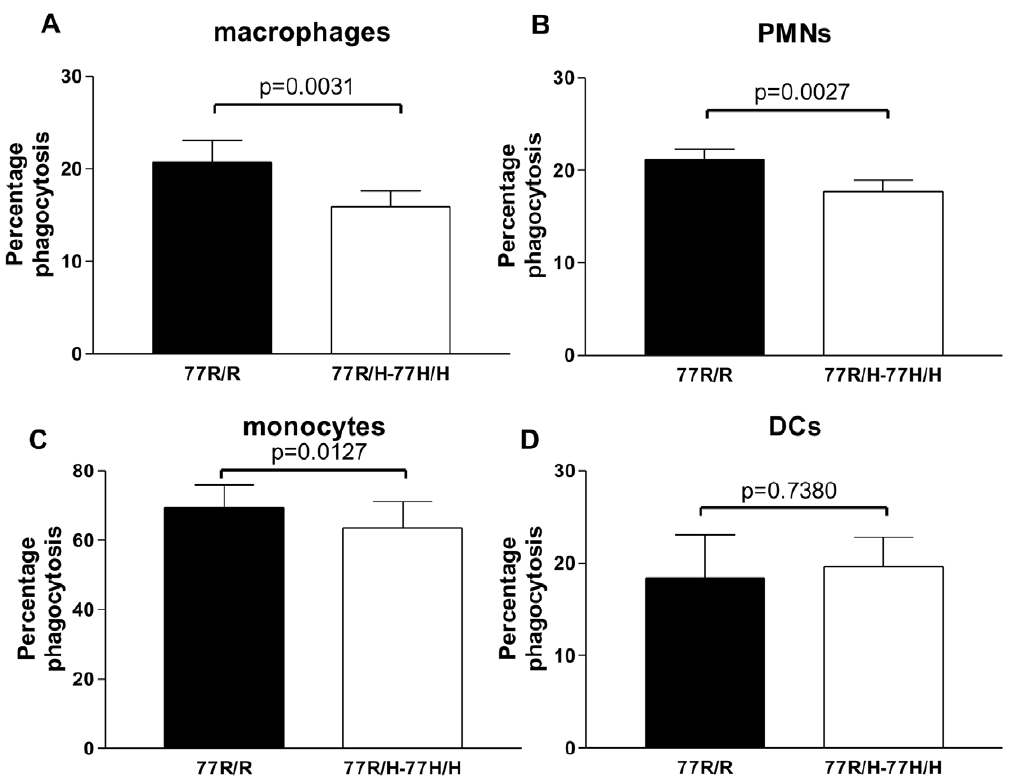
Figure 2. Phagocytosis of hiC3b-coated fluorescent beads. The uptake by macrophages (A), PMNs (B), monocytes (C) and DCs (D) was quantified by flow cytometry and the data are represented as percentage of phagocytosis. Data are expressed as mean + / 2 SEM. Filled columns 77R/R individuals, open columns 77R/H-77H/H individuals. Paired T test was applied and the p values are indicated.